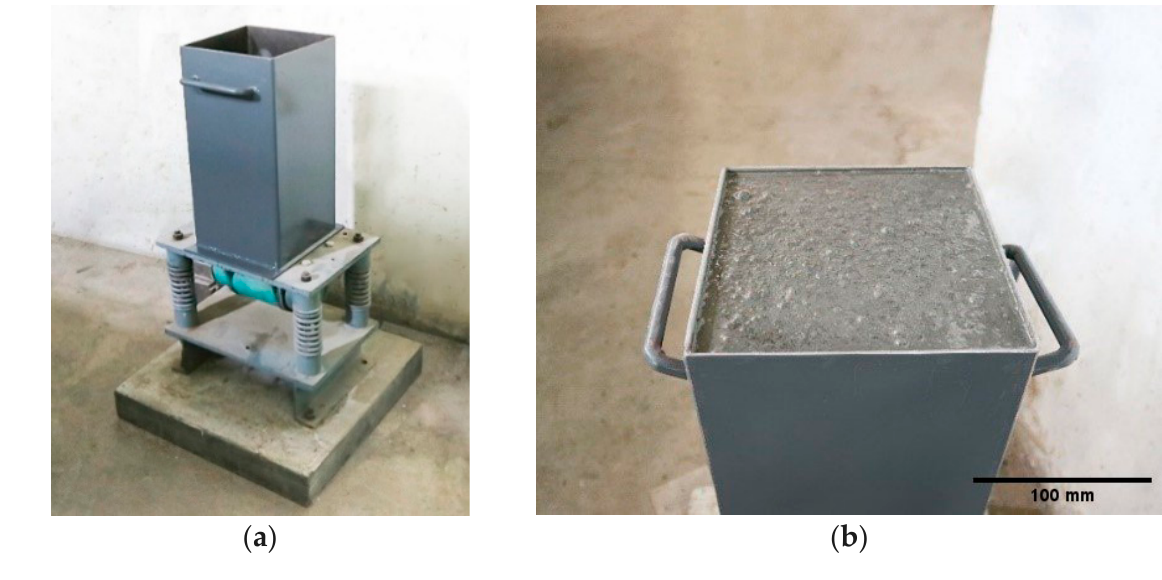
Table 8. Measurement of the compactness of fresh concrete.